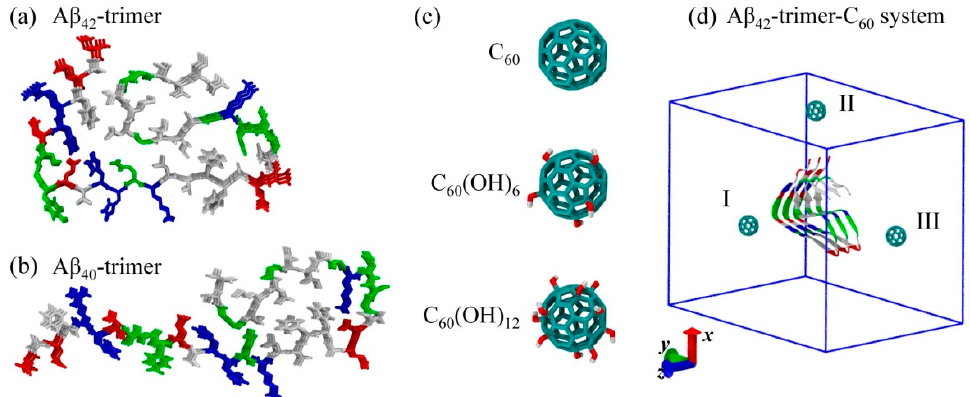
Figure 1. Molecular structures and simulation system setup. ( a – c ) The structures of A β 42 -trimer, A β 40 -trimer and C 60 / C 60 (OH) 6 / C 60 (OH) 12 . ( d ) The initial conformation of the A β 42 -trimer-C 60 system with the C 60 molecule placed at three different positions (I-III). Color codes: positively charged residues (blue), negatively charged residues (red), hydrophobic residues (white) and polar residues (green) in A β peptides; carbon atoms (cyan), oxygen atoms (red) and hydrogen atoms (white) in fullerene/fullerenol. For clarity, water molecules in the simulation box are not displayed; box vectors are shown, and z -axis is the fibrillar elongation direction.